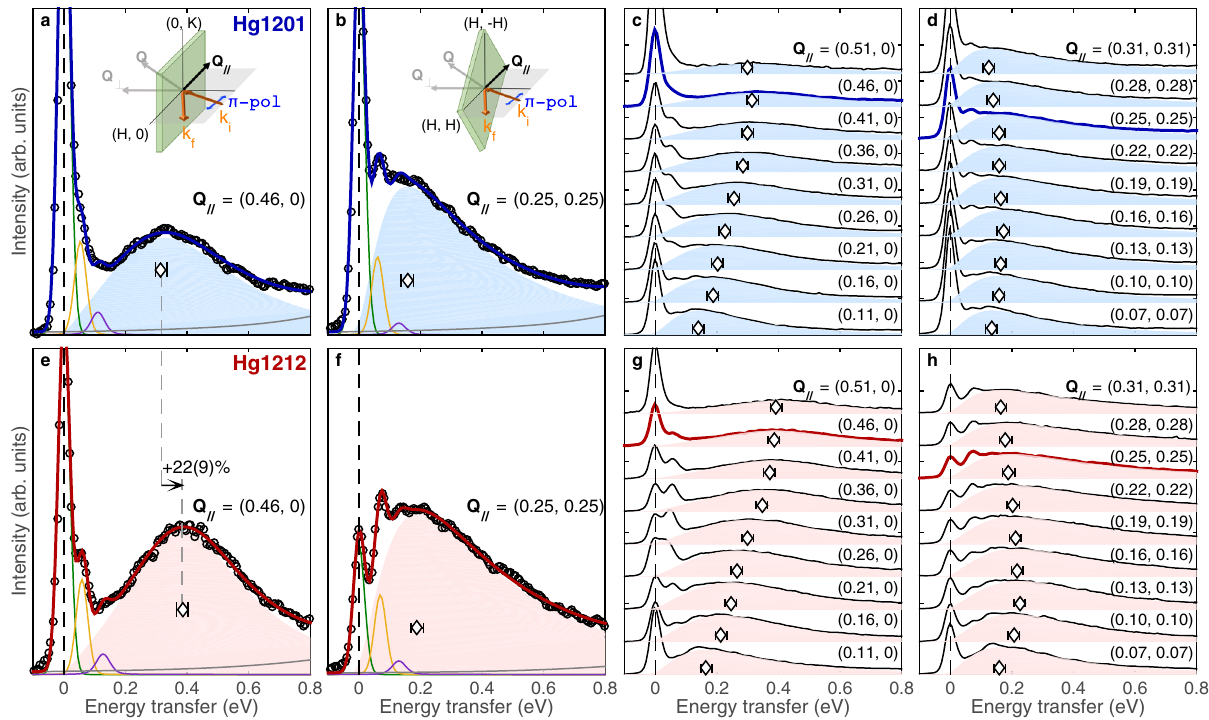
Fig. 1 RIXS spectra measured at T = 13 K with π -polarized incident x -rays. a , b Representative data measured on Hg1201 with in-plane momentum transfers Q // = (0.46, 0) and (0.25, 0.25), respectively, in reciprocal lattice units (r.l.u.). The data are normalized to the intensity of dd excitations at higher energies (Supplementary Fig. 2), and then fi tted to a sum of an elastic peak (green), a single-phonon peak (yellow), a two-phonon peak (magenta), a paramagnon peak (shaded area, the diamond symbol indicates the peak maximum), and a weakly energy-dependent background (gray). Details of the fi tting are presented in Methods, and the results are shown in Supplementary Figs. 3 – 6 and Supplementary Table 1. Insets illustrate the scattering geometry, where the detector is placed at a fi xed 2 θ angle of 154° from the incident beam. The desired Q // is reached by rotating the sample around the vertical axis. c , d Spectra at a series of Q // along high-symmetry directions, vertically offset for clarity. The fi tted paramagnon peaks are displayed by shaded areas along with the data. e – h Same as a – d , but for Hg1212. Error bars represent uncertainty in the estimate of the energies of the paramagnon signal ’ s intensity maxima (1 s.d.), see Methods for details.